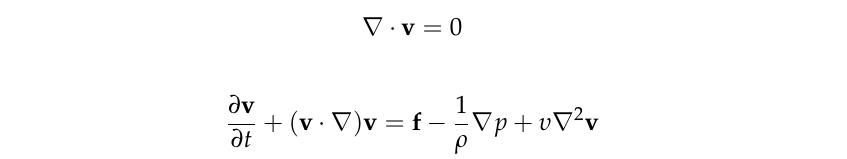
Figure 1. The ski attitude angles and computational mesh: ( a ) definition of attitude angles, ( b ) com- putational mesh of spherical fluid domain, and ( c ) mesh refinement around the ski.